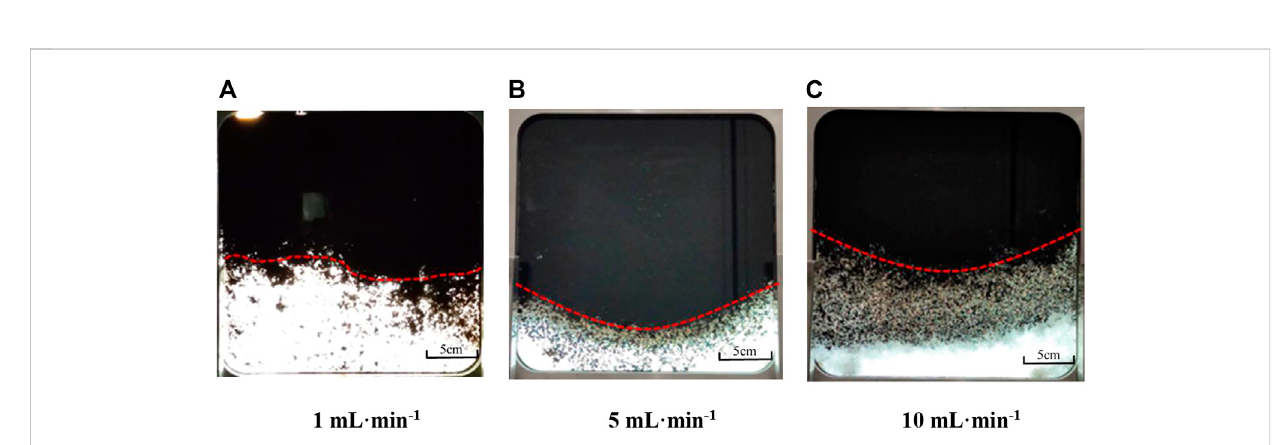
FIGURE 8 Results of water fl ooding with different fl ow rates. (A) 1 mL min − , (B) 5 mL min − , (C) 10 mL min −